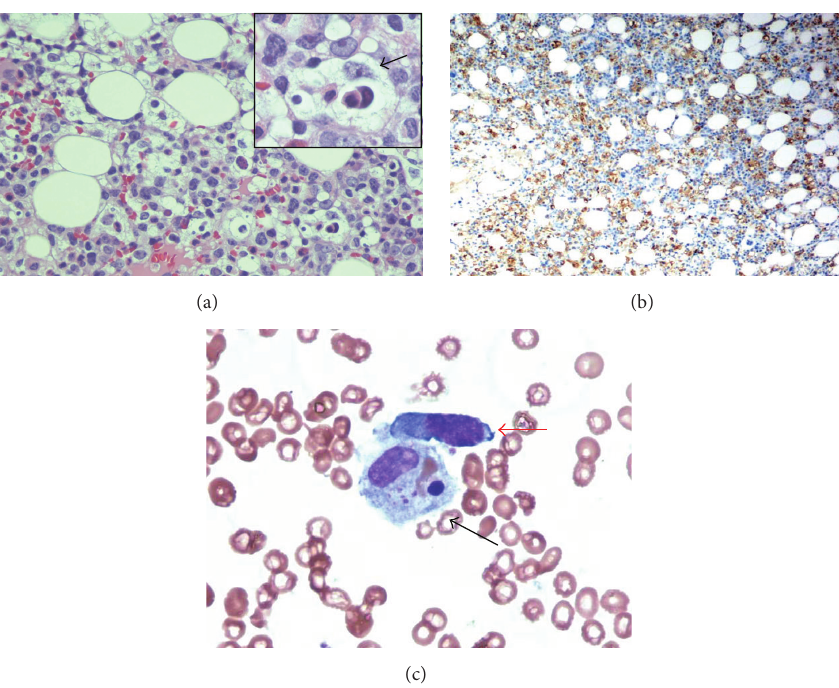
Figure 1: Histologic features of bone marrow. (a) Bone marrow biopsy demonstrated hypocellular marrow with prominent lymphohistiocytic infiltrates. Black arrow in the inset pointed to a histiocyte with engulfed hematopoietic elements. (b) Immunohistochemical stain of CD68 showed increased histiocytes. (c) Bone marrow aspirate smears highlighted hemophagocytosis (black arrow) and atypical lymphoid cell (red